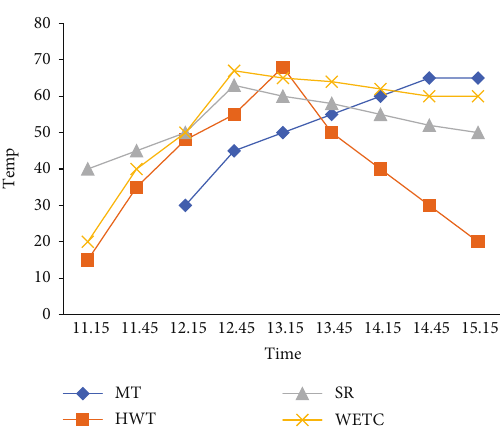
Figure 9: Performance evaluation of milk pasteurization by ETC (MT-milk temperature; HWT-hot water temperature; SR-solar radiation; WETC-water from ETC temperature).